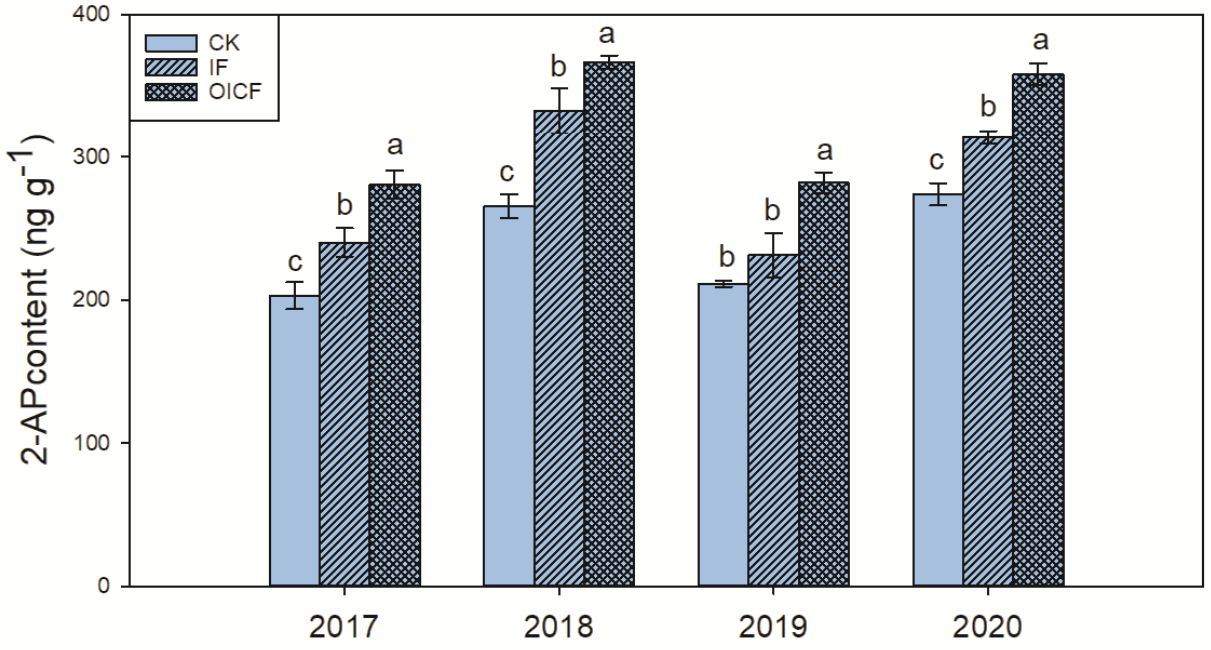
Figure 3. Effects of new organic-inorganic compound fertilizer on aboveground biomass of fragrant rice in 2017 ( A ), 2018 ( B ), 2019 ( C ), and 2020 ( D ). Bars sharing a common letter do not differ significantly at p ≤ 0.05.